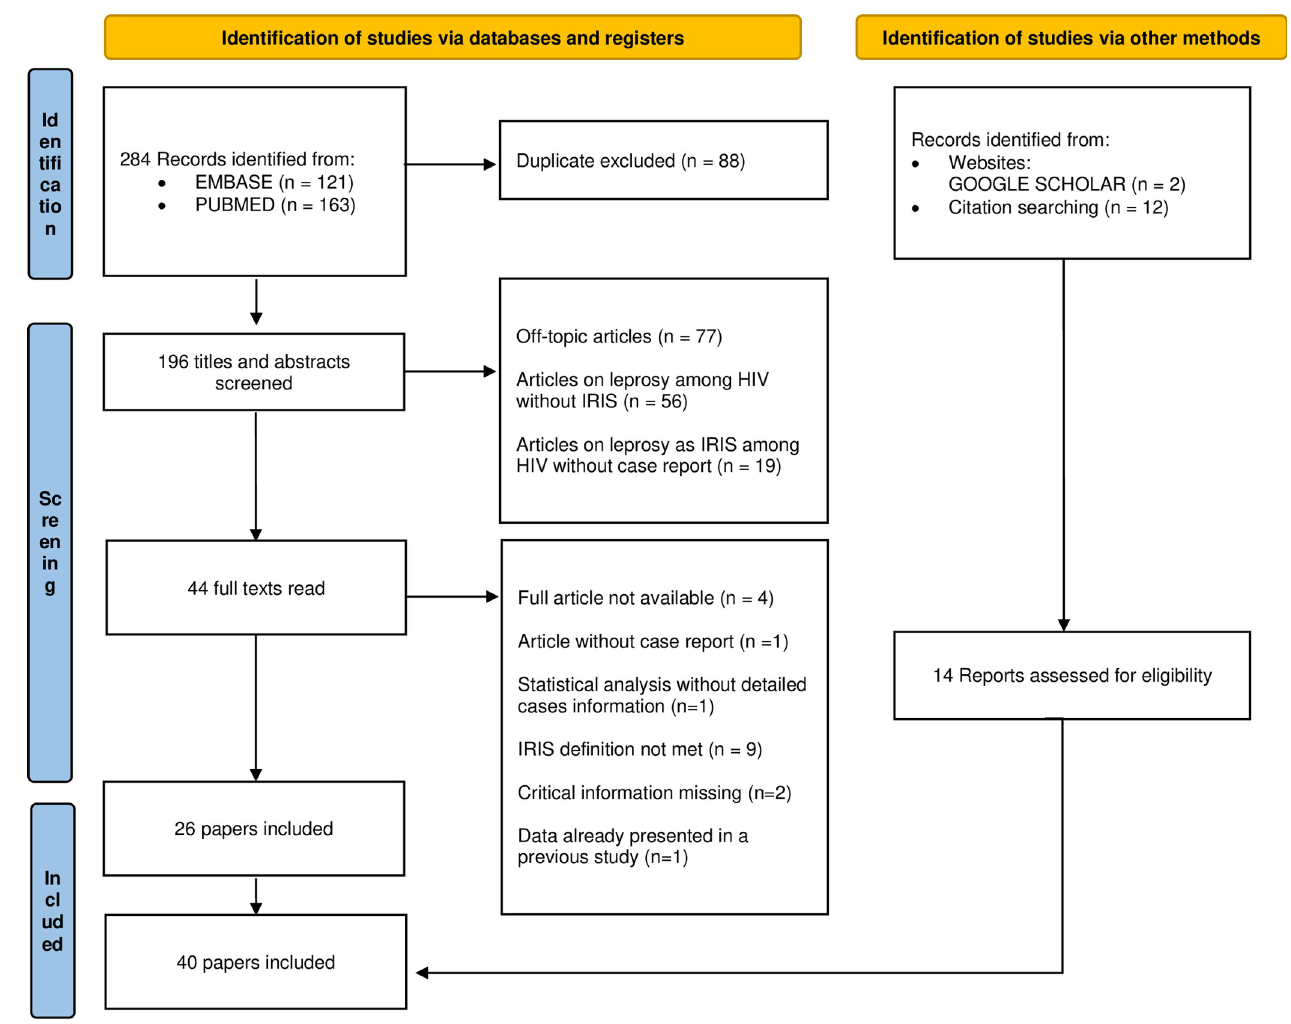
Fig 6. Flow chart of the systematic review of leprosy as IRIS according to the PRISMA 2020 criteria.